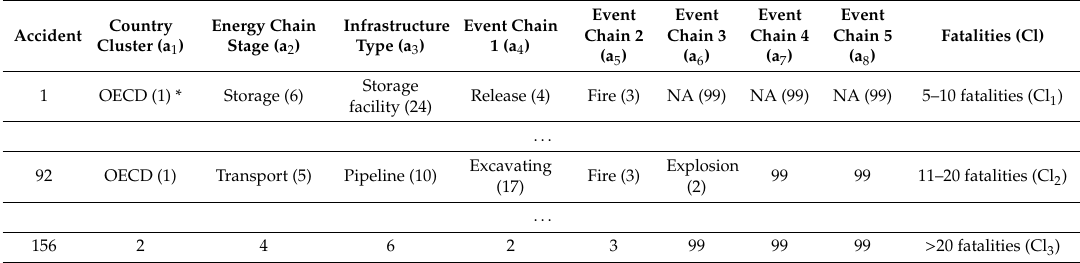
Table 1. A sample of the information table for energy accidents from Energy-related Severe Accident Database